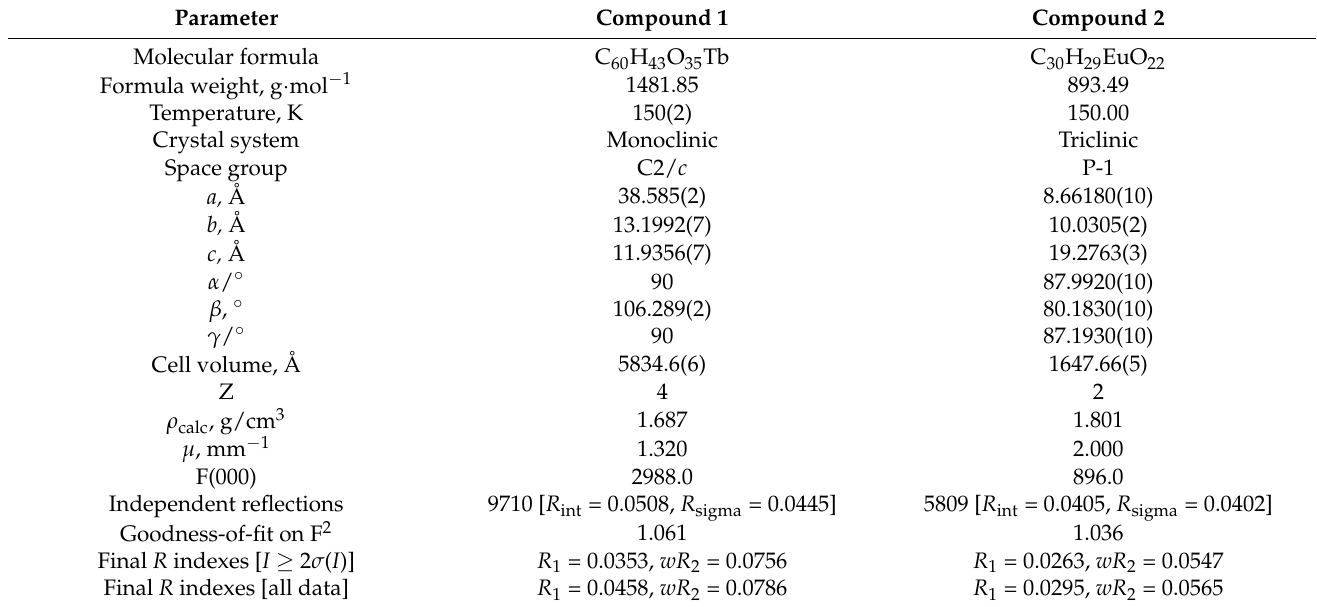
Table 1. Crystallographic data and details of the structure refinement for the compounds 1 and 2